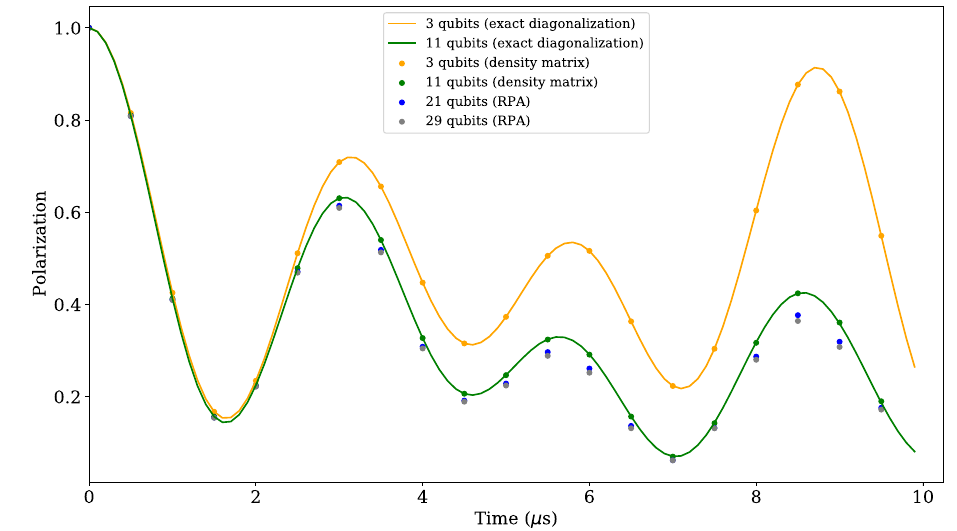
FIG. 10. Polarization functions for the unperturbed 3-, 11-, 21-, and 29-qubit CaF 2 + μ + systems. All simulations use 30 second- order Trotter steps to simulate time evolution. The 3- and 11-qubit results are obtained using a density-matrix simulation, that eliminates sampling error. The 21- and 29-qubit simulations are performed using the random-phase-approximation method, with 48 and 1 samples,